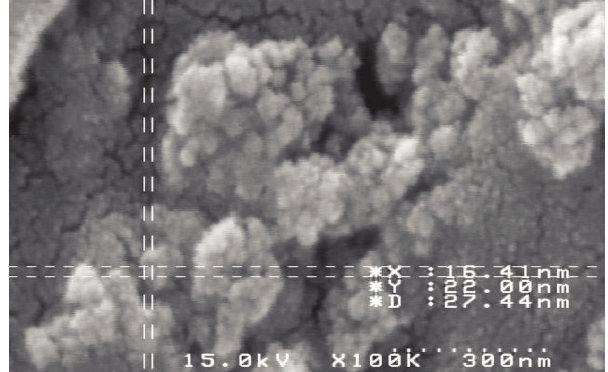
Fig. 2 - The image of magnetic nano-carboxymethylated chito- san particles by SEM microscopy. Size and morphology of Fe 3 O 4 coated by carboxmethylated chitosan.